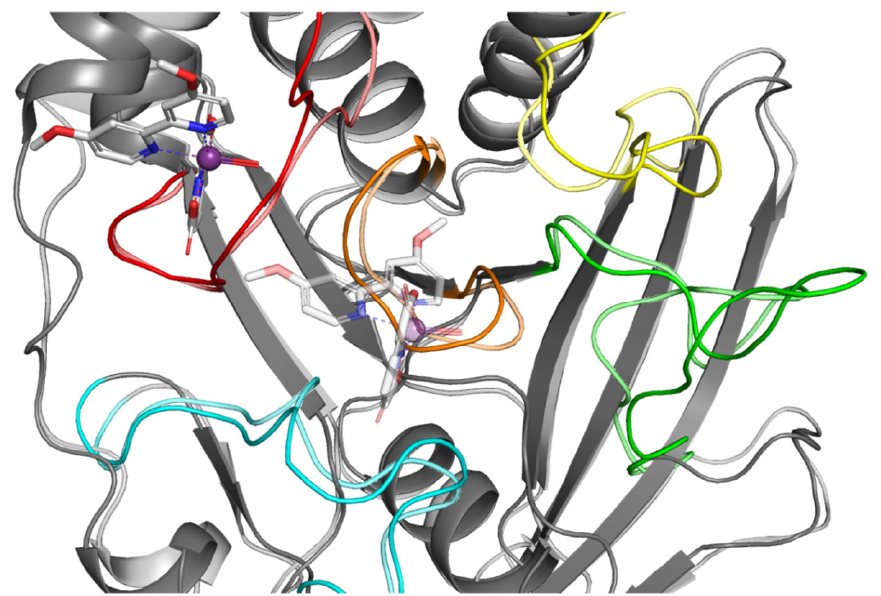
Figure 10. Result of MD simulation of Compound 4 (white sticks) and the PTP1B complex (2FJN). Transparent structures present a studied complex on start of simulation and filled structures present position after 50ns. We highlight significant loops with separate colors; P ‐ loop in orange, WPD ‐ loop in yellow, E ‐ loop in green, and Q ‐ loop in red.